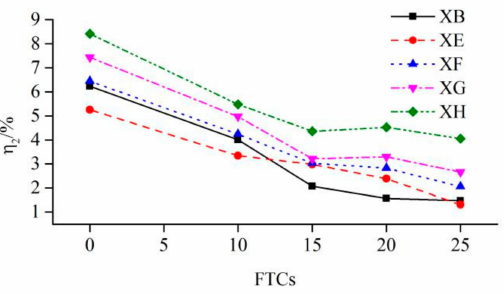
Figure 6. Curves of η 2 versus FTCs.